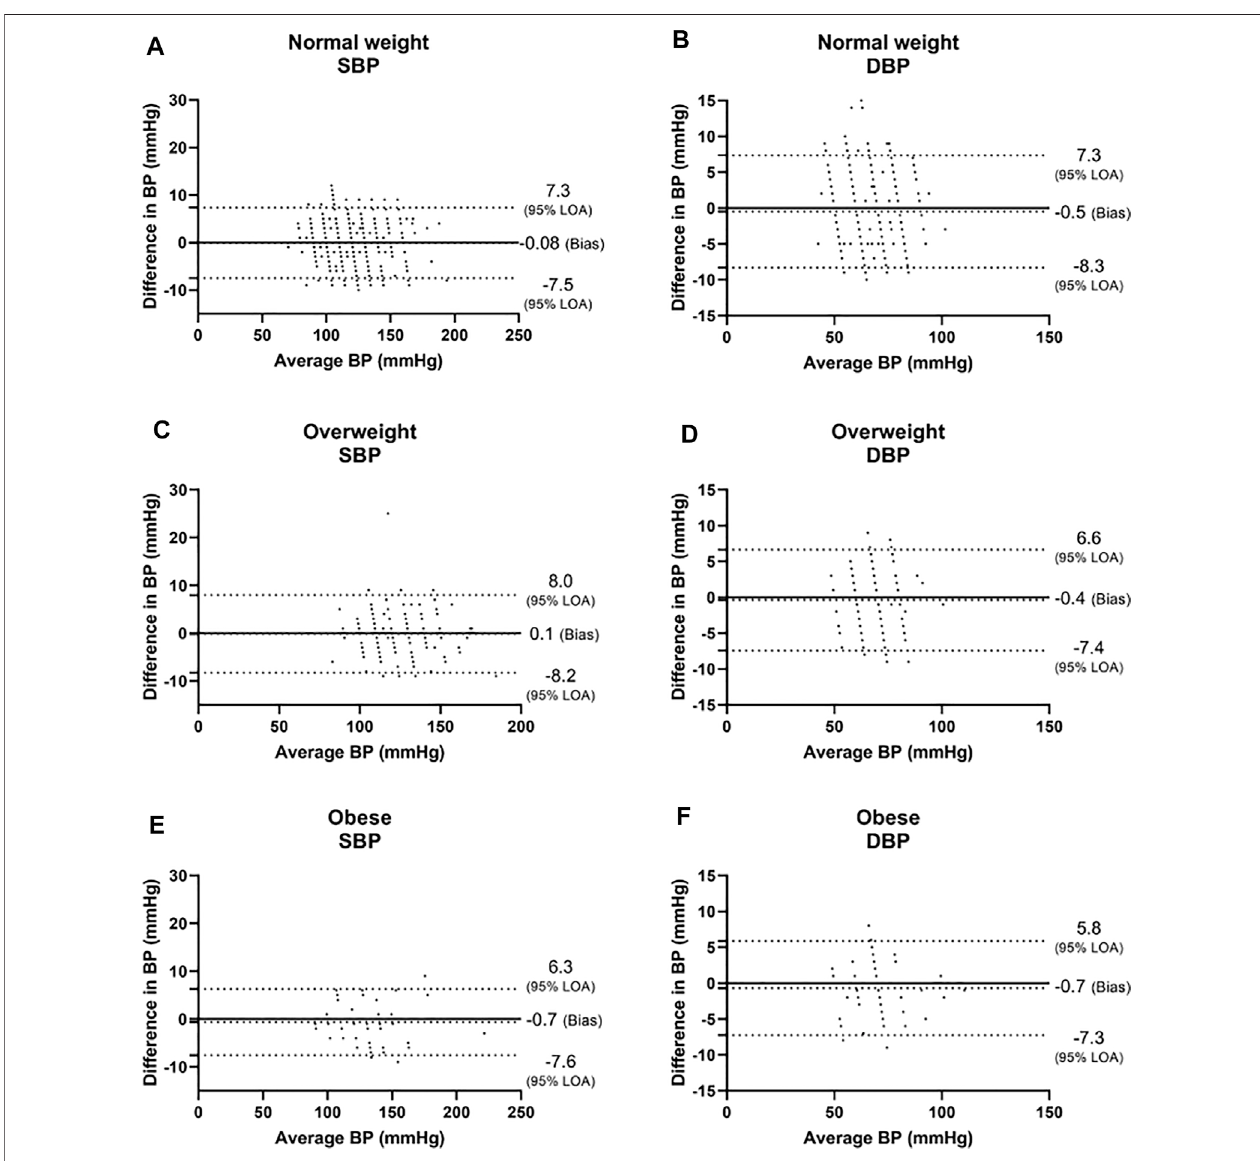
FIGURE 3 | Bland-Altman analysis of the body mass index (BMI) groups. Normal weight was de fi ned as BMI < 25, overweight was de fi ned as 25 ≤ BMI < 30, and obese was de fi ned as 30 ≤ BMI. LOA level of agreement, SBP systolic blood pressure, DBP diastolic blood pressure.